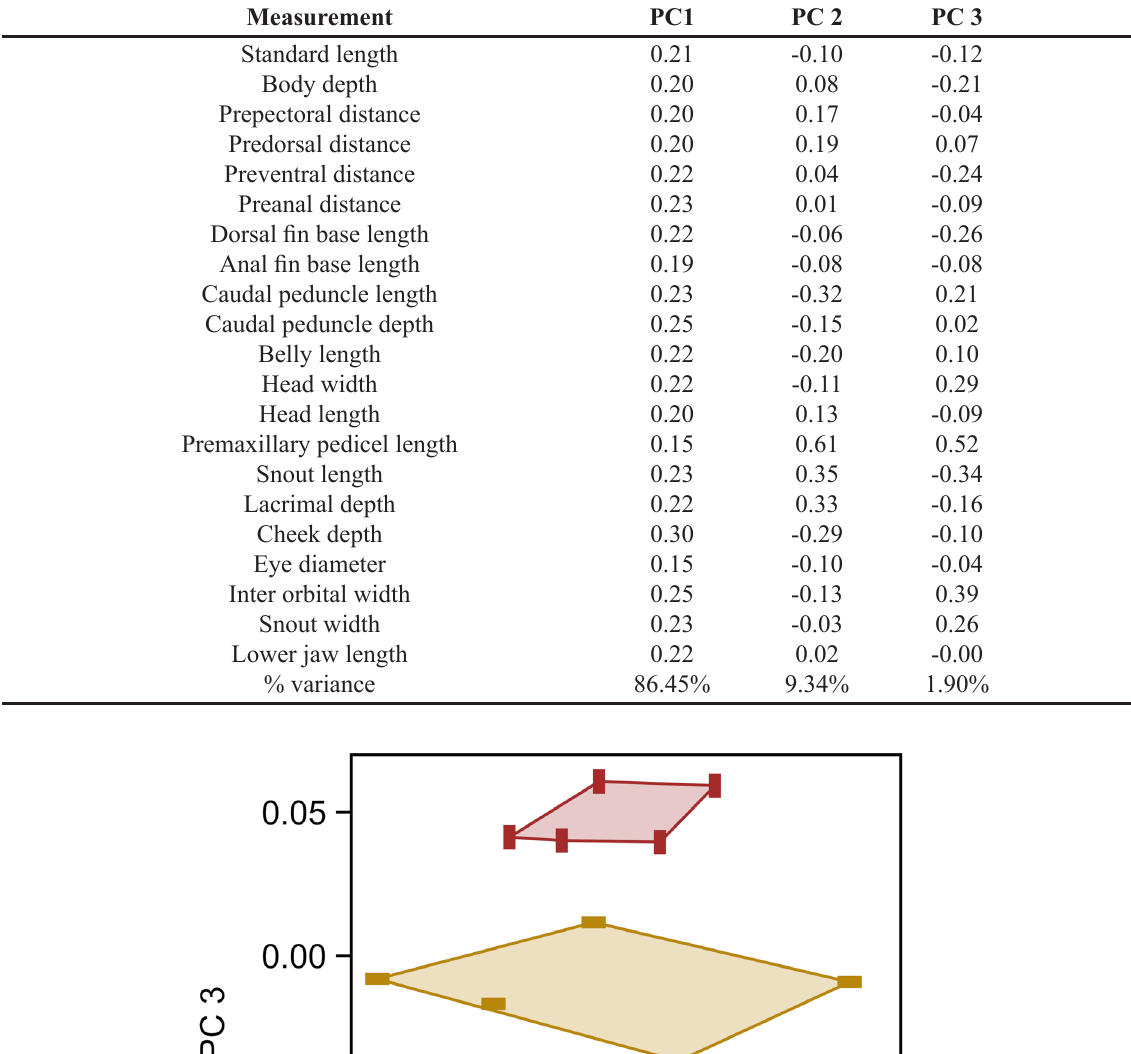
Table 2. Loadings of PC 1, PC 2 and PC 3 of the principal component analysis of 21 log-transformed measurements of both species of Caprichromis Eccles & Trewavas, 1989 and P. krampus sp. nov.